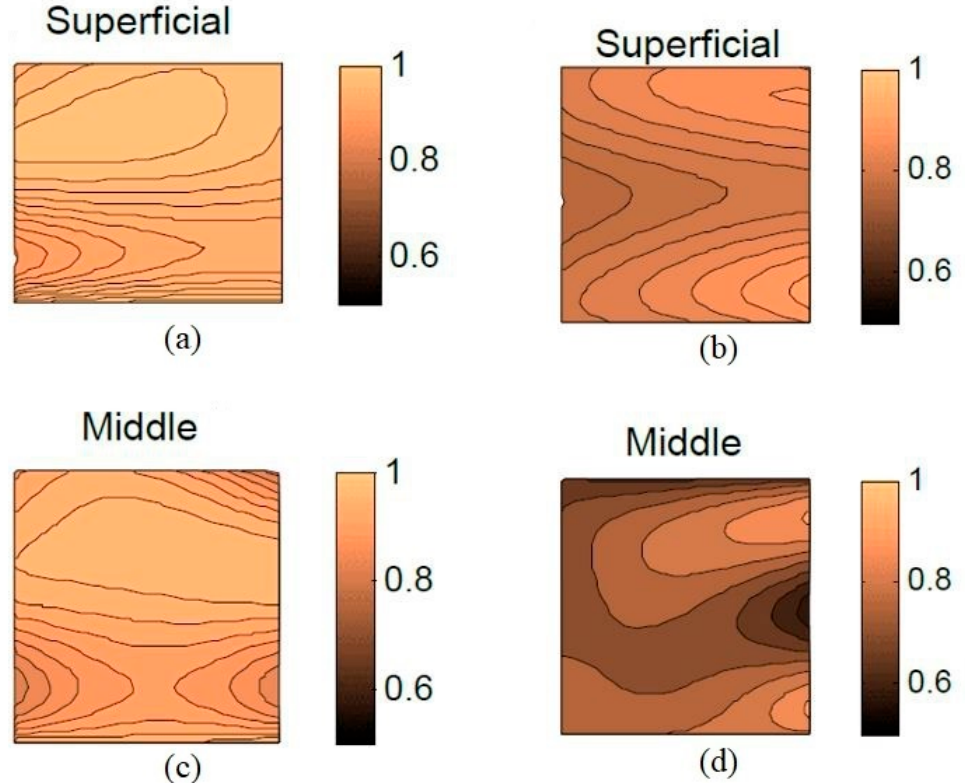
Figure 14. Glass block surface shaded areas: ( a ) and ( c ) the southern exposures; ( b ) and ( d ) the northern exposures. In ( a ) and ( b ) the measuring system is on the surface of the glass block; in ( c ) and ( d ) the measuring system is on the middle.